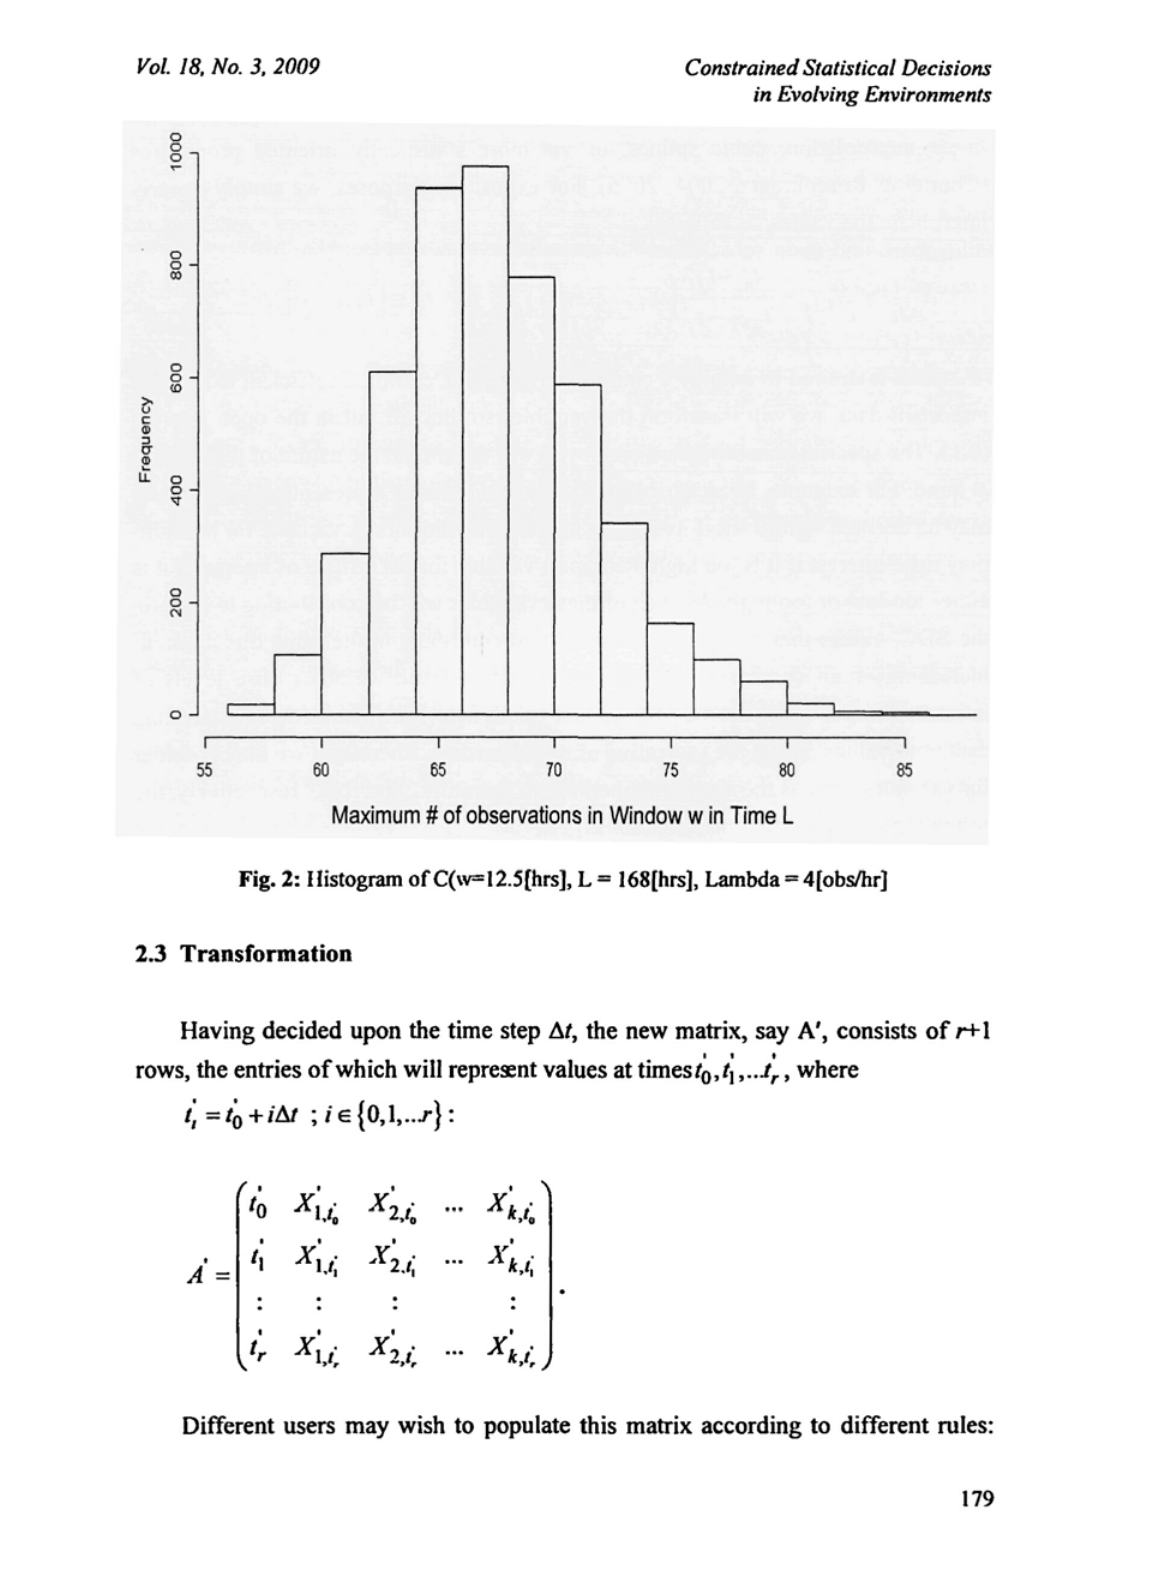
Fig. 2: Histogram of C(w=l2.5[hrs], L = 168[hrs], Lambda =